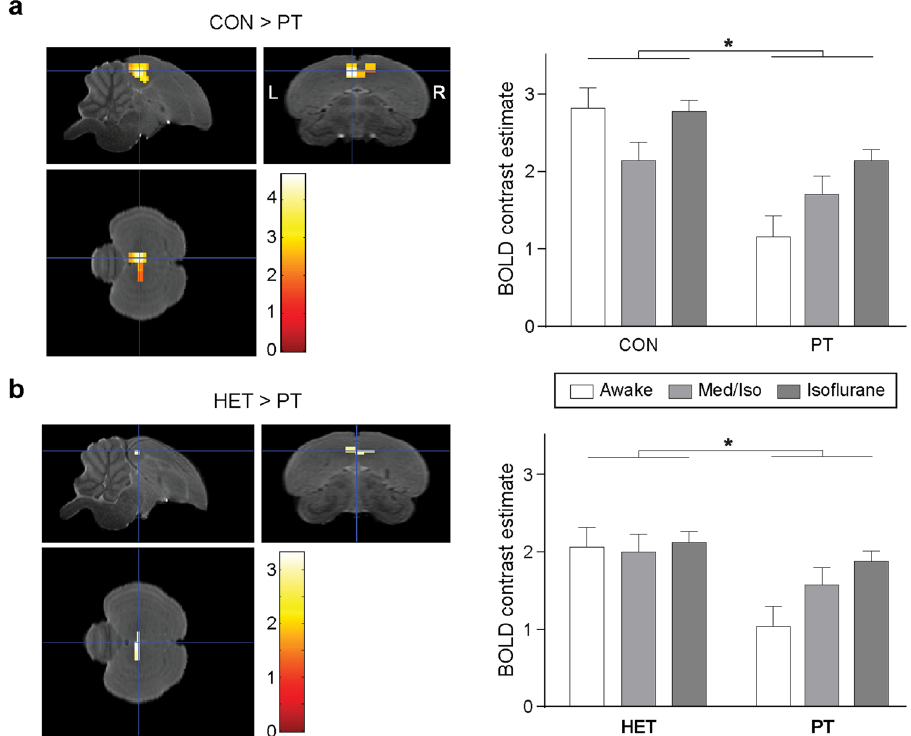
Figure 5. Conspecific and heterospecific song selectivity in the auditory forebrain. The images on the left represent statistical maps for the main CON > PT ( a ) and HET > PT ( b ) selectivity over all conditions superimposed on images of the population based template. Only voxels with a T value > 1.66 ( p uncorrected < 0.05) are displayed. Graphs on the right show the relative response amplitude of responses for the local peak voxel. The zero level corresponds to the estimated mean during rest periods and the error bars to standard errors across subjects ( * p FWE <